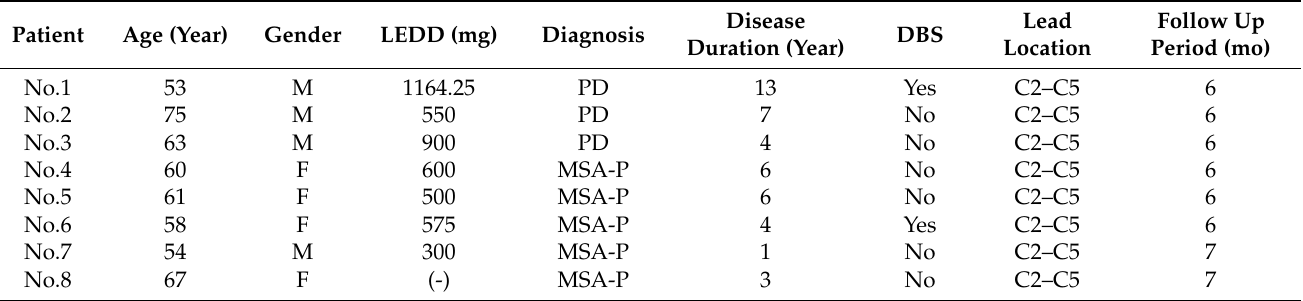
Table 1. Demographic and clinical characteristics.